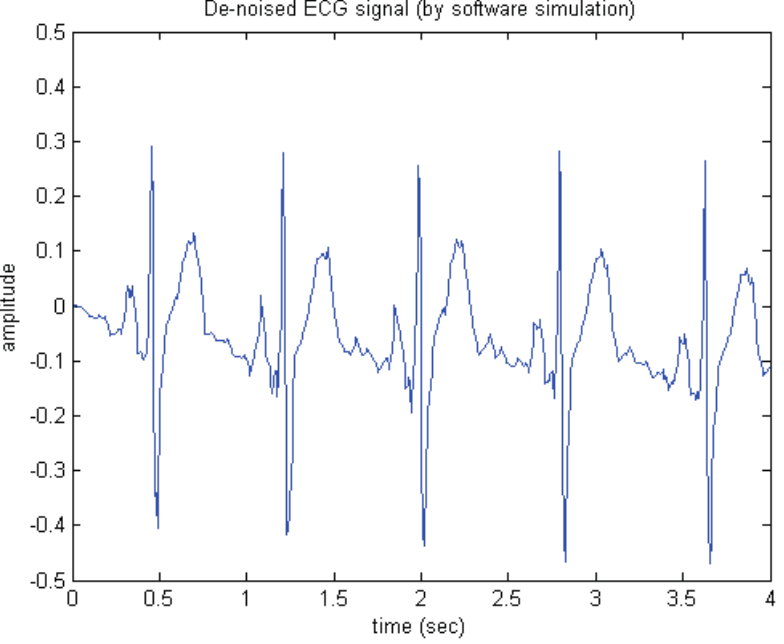
Figure 11. De-noised ECG signal (by software simulation).